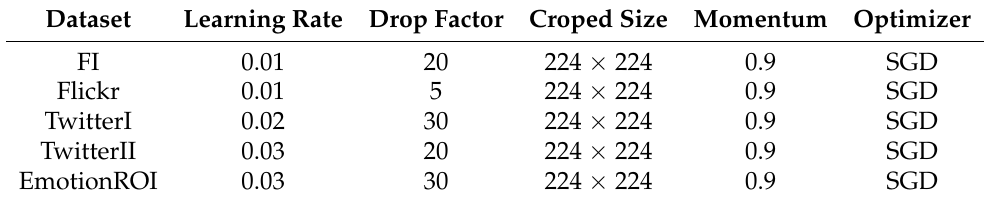
Table 2. Setting of training parameters on the dataset of FI, Flickr, EmotionROI, Twitter I, Twitter